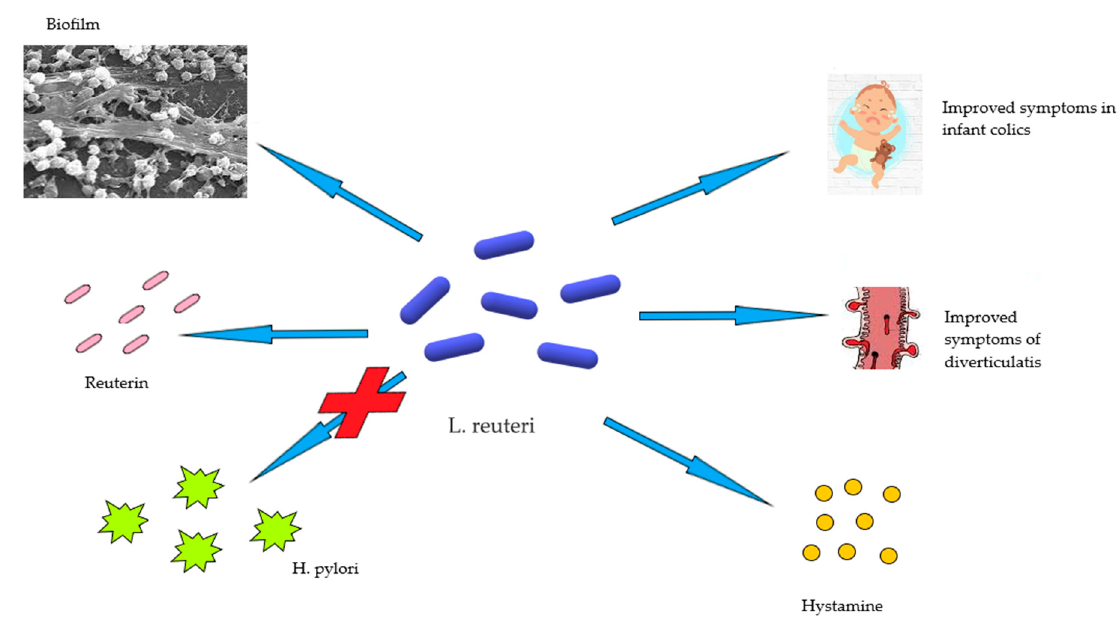
Figure 1. The role of L. reuteri in human health and disease.